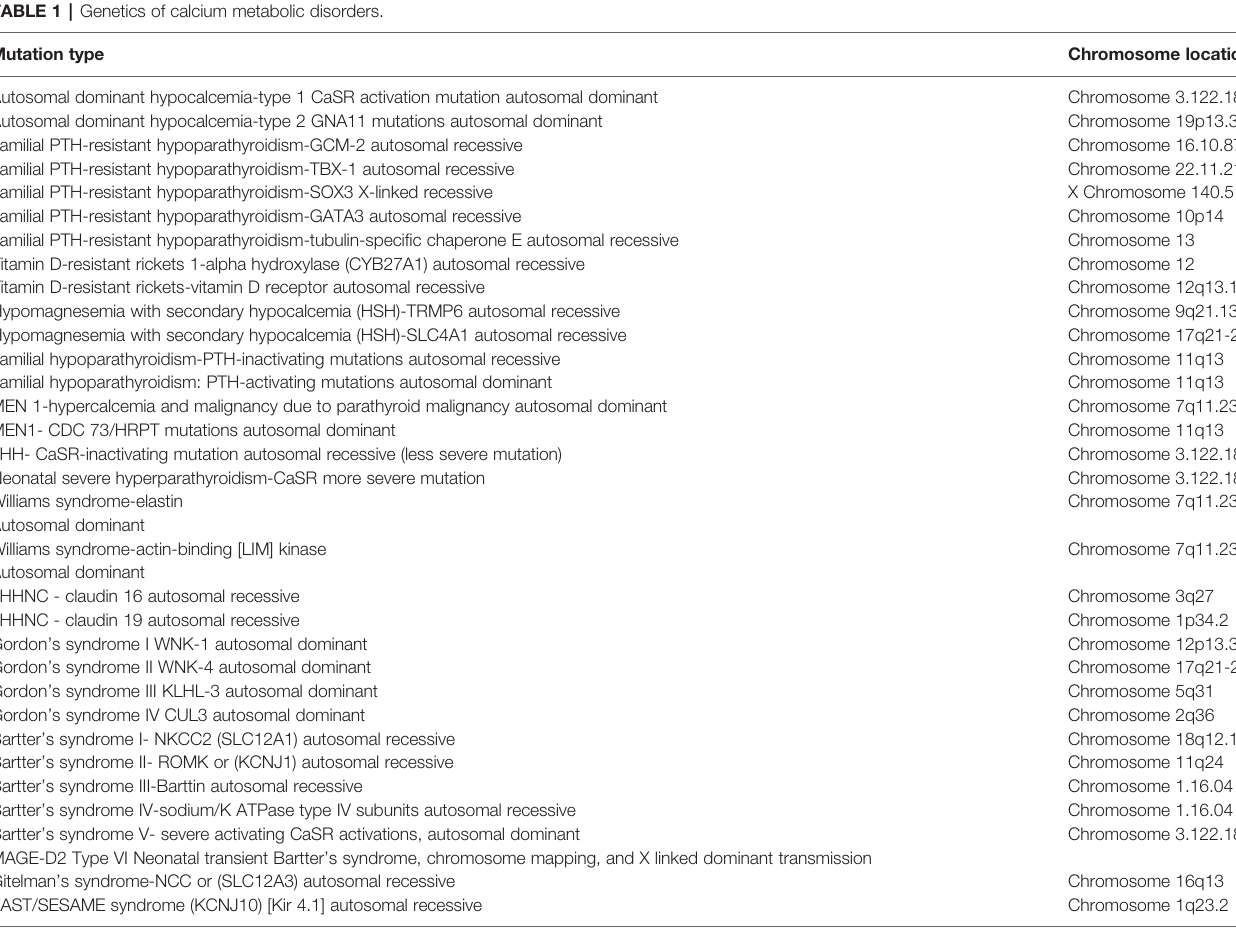
CaSR, calcium-sensing receptor; EAST, epilepsy, ataxia, sensorineural deafness, tubulopathy; FHH, familial hypercalcemia with hypocalciuria; FHHNC, familial primary hypomagnesemia with hypercalciuria and nephrocalcinosis; GATA 3, GATA-binding protein 3; GCM2, glial cells missing 2; GNA11, gene producing G protein 11; HRPT, hypoxanthine phosphoribosyltransferase; HSH, hypomagnesemia with secondary hypocalcemia; MEN, multiple endocrine neoplasia; NCC, thiazide-sensitive cotransporter; NKCC2, sodium potassium two chloride transporter; PTH, parathyroid hormone; ROMK, renal outer medulla potassium channel; SESAME syndrome (seizures, sensorineural deafness, ataxia, mental retardation, and electrolyte imbalance); SLC4A1, band 3 anion transport protein; SOX3, SRY Box 3; TBX-1, T box 1 mutations; TRPM6, TRP magnesium-permeable channel 6; WNK 1, lysine-de fi cient protein kinase 1; WNK 4, lysine-de fi cient protein kinase 4 [note chromosome mapping convention q, long arm; p, short